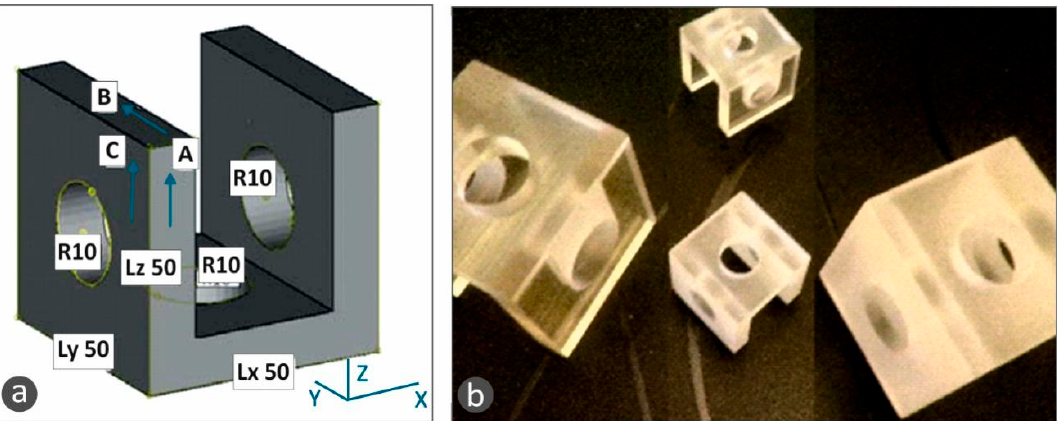
Figure 2. ( a ) Shape and direction of Ra measurements [1,12]; ( b ) specimens used for dimensional and surface roughness measurements [1,12].